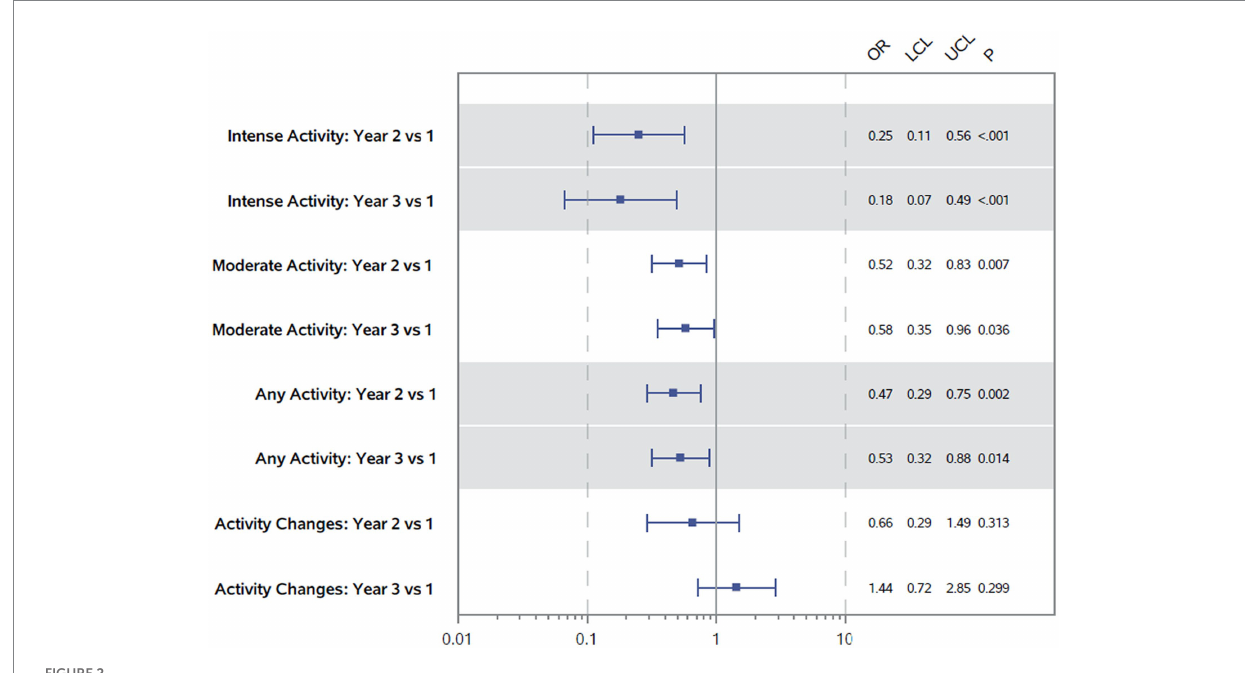
FIGURE 2 Physical activity levels among cohort participants,